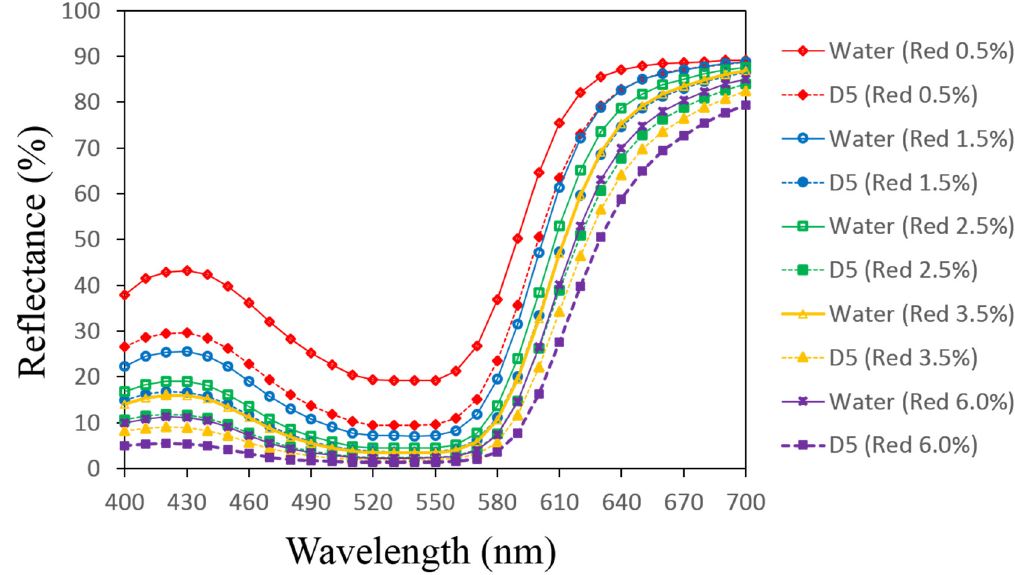
Figure 3. Reflectance curves of the red color of batch samples dyed in water and D5 medium.